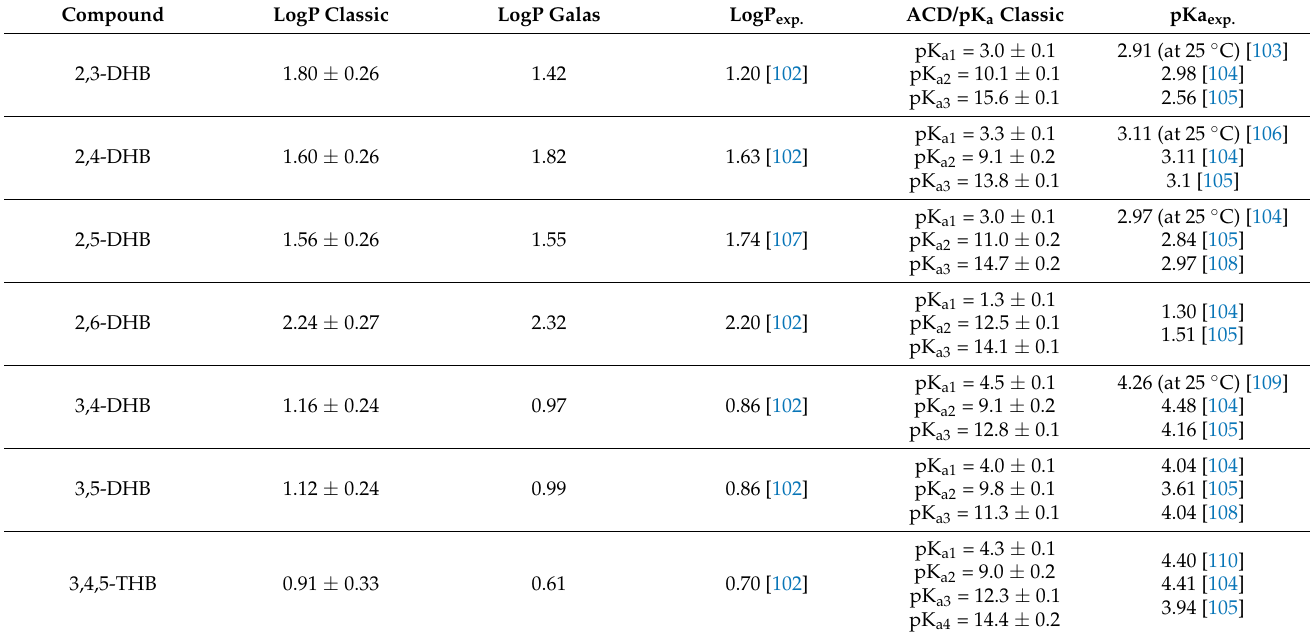
Table 7. Theoretical (calculated in ACD/Labs or Percepta: logP classic, logP galas, pKa classic) and experimental logP and pKa values.